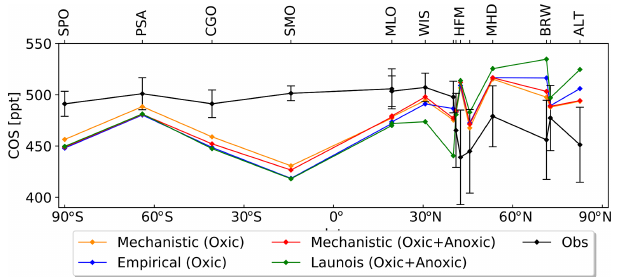
Figure 9. Comparison of the latitudinal variations in the COS abun- dances simulated by LMDZ at NOAA sites with the observations (black). The LMDZ COS abundances have been vertically shifted such that the means of the simulated concentrations are the same as the mean of the observations. The error bars around the black curve represent the standard deviation over the whole studied pe- riod at each NOAA site. The orange curve is obtained using the oxic soil fluxes of the mechanistic model. The red curve is obtained using the oxic and anoxic soil fluxes of the mechanistic model. The blue curve is given by LMDZ using the oxic soil fluxes from the Berry empirical model. The green curve is obtained using the soil fluxes from the empirical approach of Launois et al. (2015). For more clarity, the names of the stations KUM (19.74 ◦ N, 155.01 ◦ W), NWR (40.04 ◦ N, 105.54 ◦ W), LEF (45.95 ◦ N, 90.28 ◦ W), and SUM (72.6 ◦ N, 38.42 ◦ W) are not shown in this figure due to their prox- imity to other stations (Fig. B1 and Table B1 in Appendix